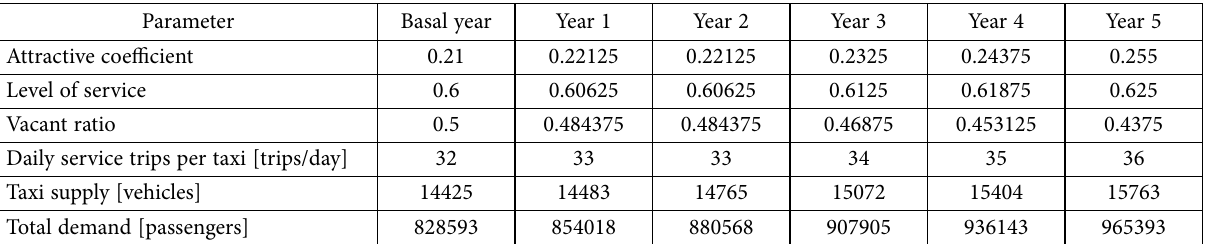
Table 4. Simulation results of the basal scenario of Harbin taxi